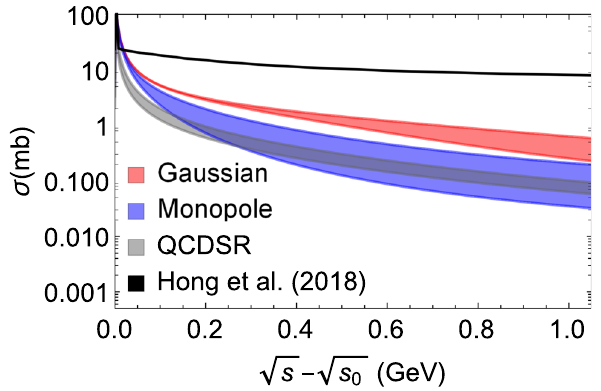
Fig. 6 Sumofthecrosssectionsfortheprocessesobtainedinthiswork ( T cc π → DD + DD ∗ + D ∗ D ∗ ) and in Ref. [11] ( T cc π → D π + D ∗ π ), √ √ s above the threshold energy s 0 of as a function of the CM energy eachprocess. Thelegenddenotestherespectivefunctionalform ofform factors used to calculate the cross